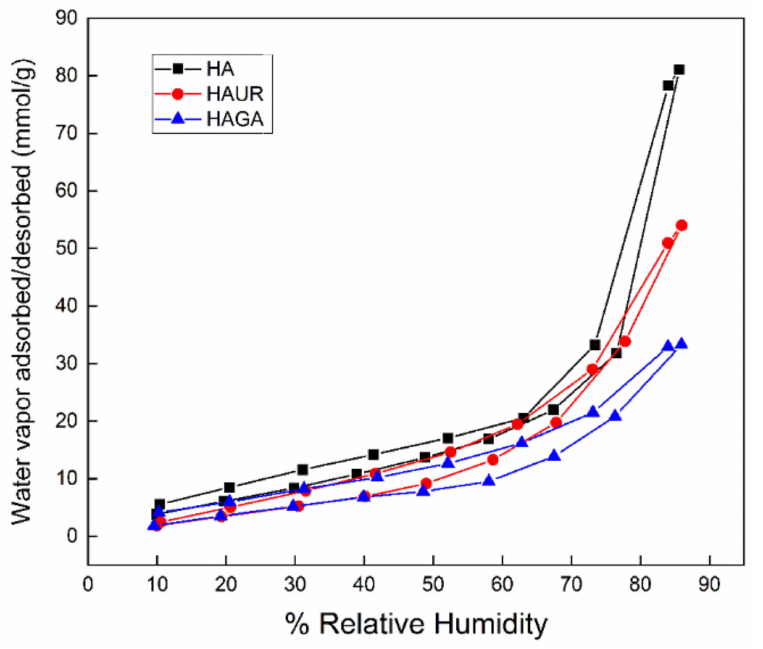
Figure 11. Water sorption/desorption isotherms of HAGA, HAUR, and HA